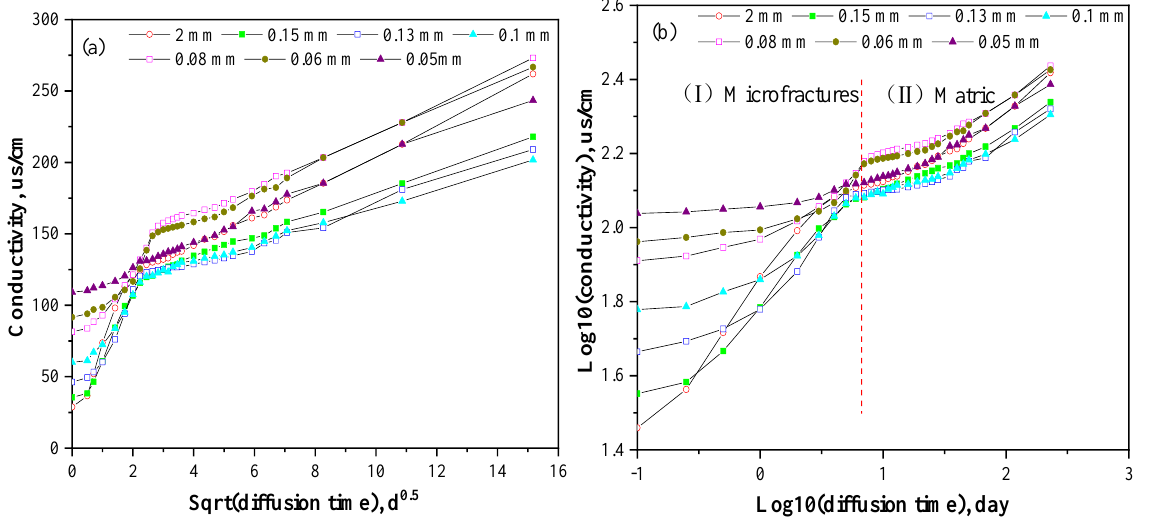
Figure 8. Ion diffusion curves of sandstone sample with different particle sizes: ( a ) conductivity over time 0.5 and ( b ) double logarithm of conductivity with time.